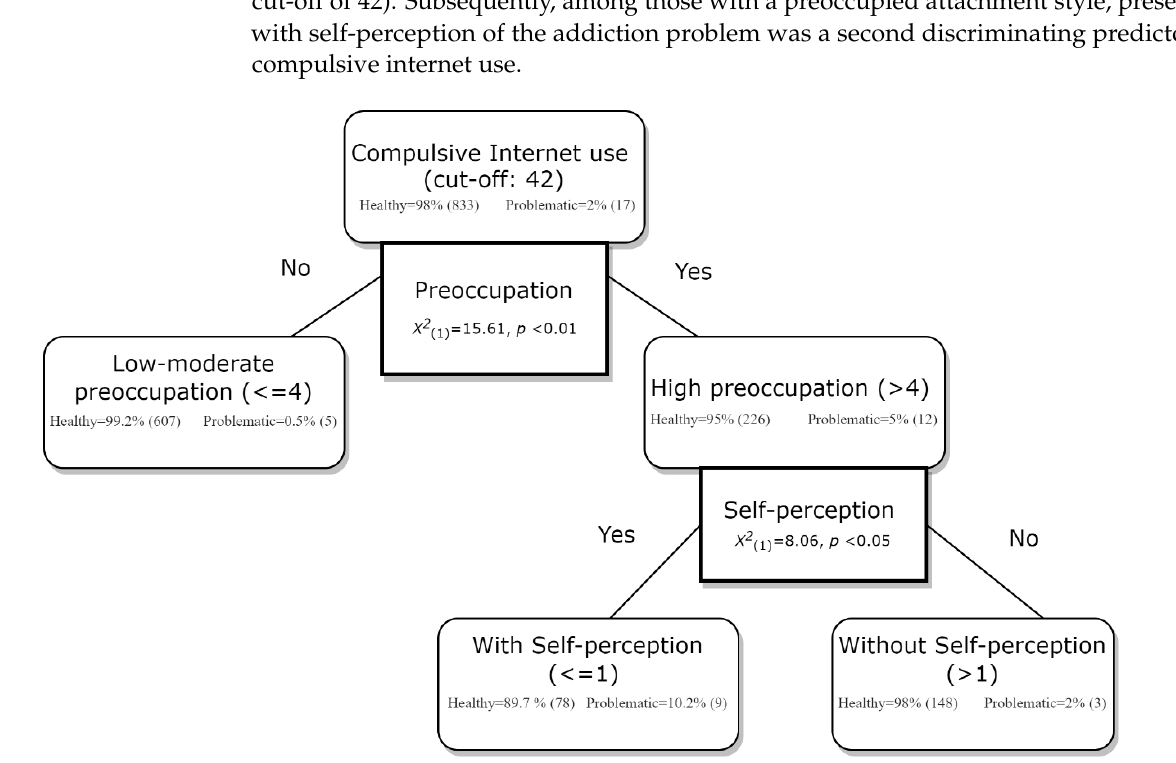
Figure 1. Discriminating factors for compulsive internet use in adults (subgroups of healthy and problematic users—with percentage and